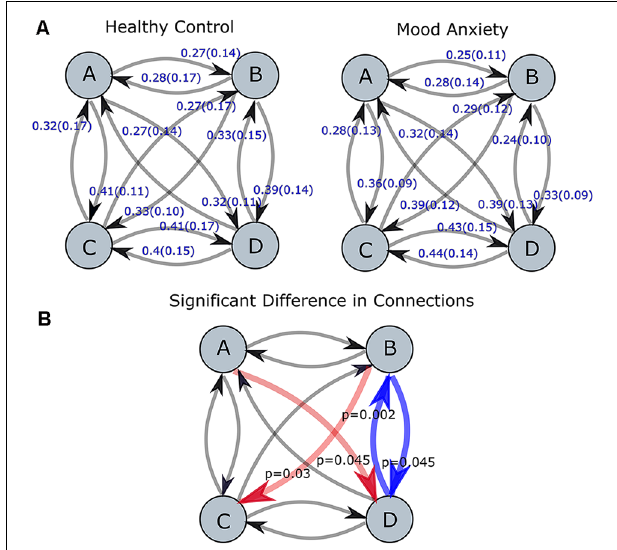
FIGURE 4 | Transition probabilities for MA and HC groups are shown in part (A) . The red and blue arrows (red represent an increase, while blue represent a decrease for MA group as compared to HC one) in part (B) represent the connections with the statistically significant difference between two groups ( p -values corrected for multiple comparisons using Bonferroni-Holm). The level of significance was set to p < 0.05.